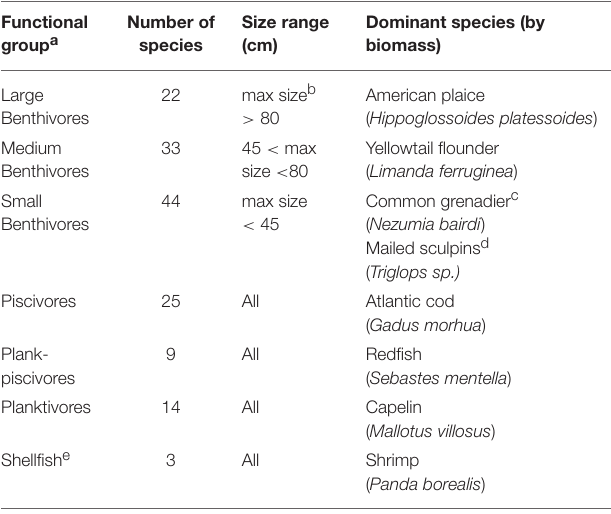
TABLE 1 | Functional groups used to represent the fish community structure of the Grand Bank, Newfoundland. Number of Size range Dominant species (by Functional species (cm) biomass) group a ( Figure 3 ): the North Atlantic Oscillation (NAO), sea surface salinity (SSS), salinity at 150 m (S150), sea surface temperature (SST), and the timing of the sea ice melt (Time Ice ). The NAO represents basin scale atmospheric circulation patterns that influence winds, salinity, temperature, and sea ice (Hurrell, 1995; Petrie, 2007). The remaining indicators characterize physical environmental factors local to the Grand Bank, which are thought to have played a critical role in the collapse of fish biomass in the 1990s (e.g., Halliday and Pinhorn, 2009). Time Ice was included as a proxy of the timing of the spring phytoplankton bloom (Wu et al., 2007) because there are no other